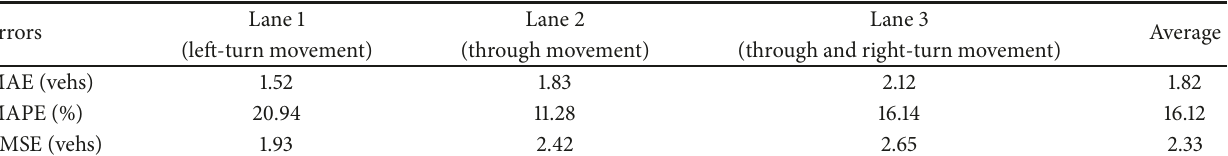
Table 4: MAE, MAPE, and RMSE of maximum queue length.